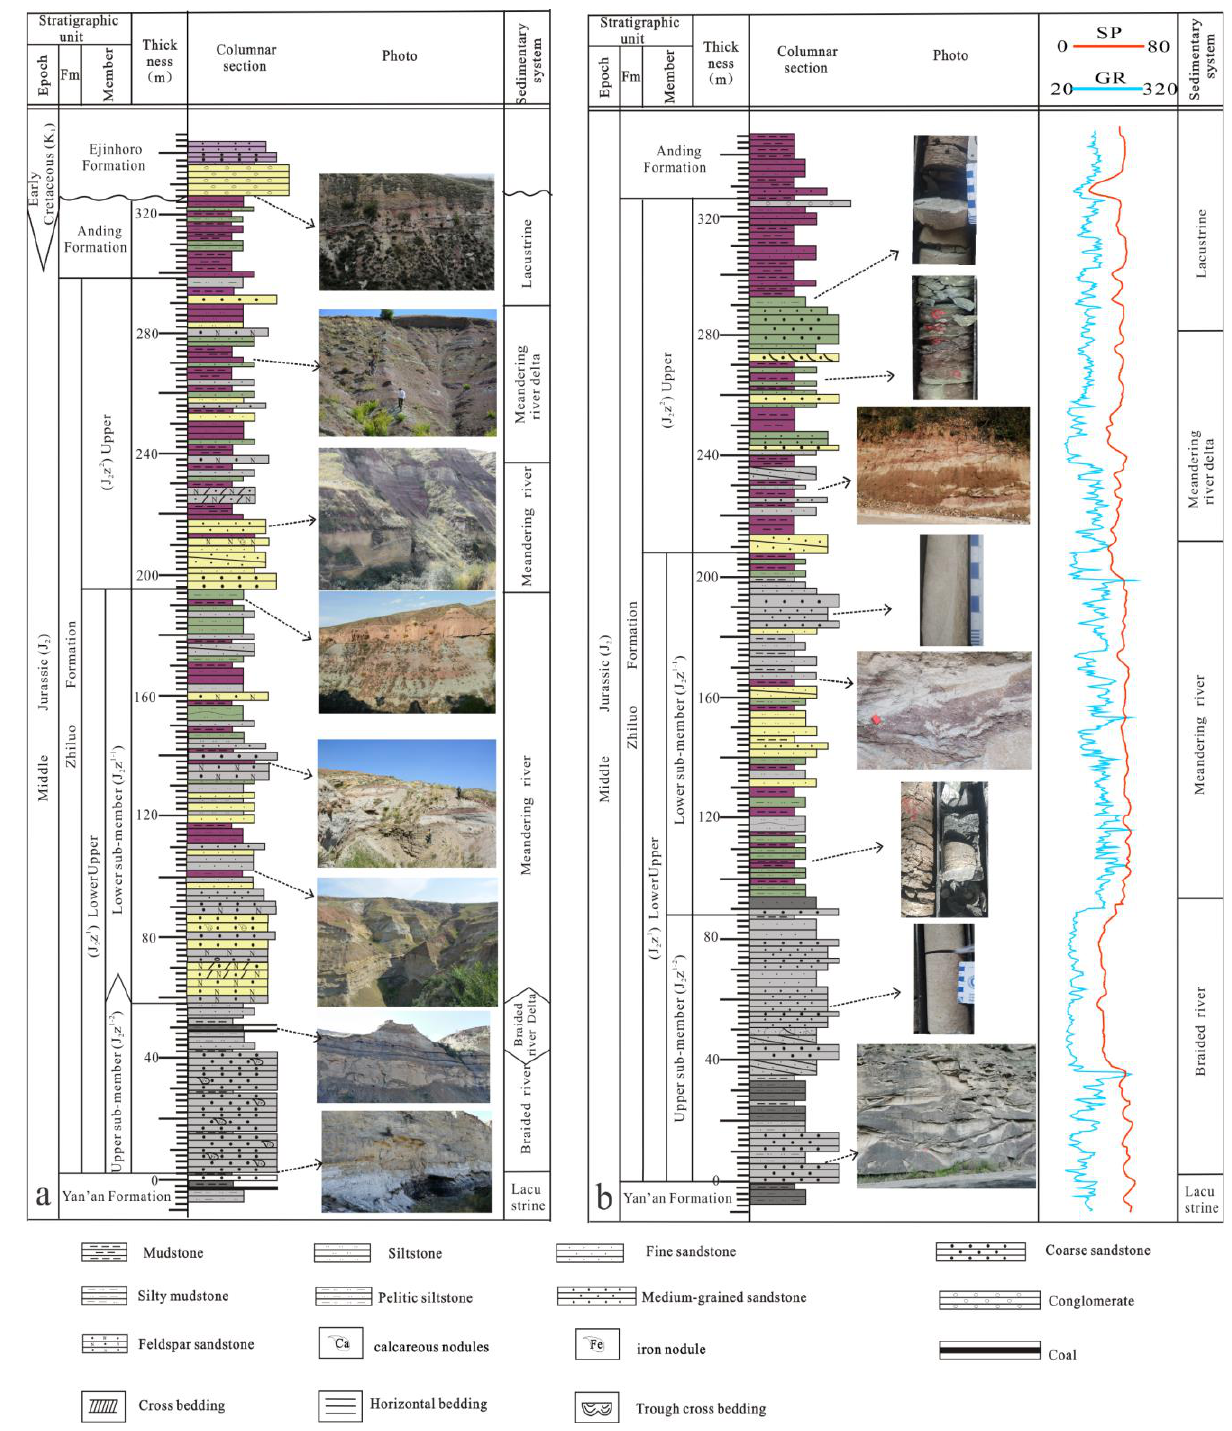
Figure 2. ( a ) Composite stratigraphic section of the Jurassic Zhiluo Formation in the basin’s northern part (modified from Shenshangou section ○ A and Gaotouyao section ○ B ; see Figure 1c); ( b ) Composite stratigraphic section of the Jurassic Zhiluo Formation in the basin’s southern part. (2) The lower part of J 2 z 1-2 comprises light greyish-green and light-yellow medium and fine sandstone, with medium-scale crossbedding. The upper part of J 2 z 1-2 primarily contains greyish-yellow, greyish-green, brown and dark purple siltstone and mud- stone, characterised by a thin interbedding of medium-fine sandstone, siltstone and argillaceous rock and shows horizontal bedding, small cross-bedding, and climbing-